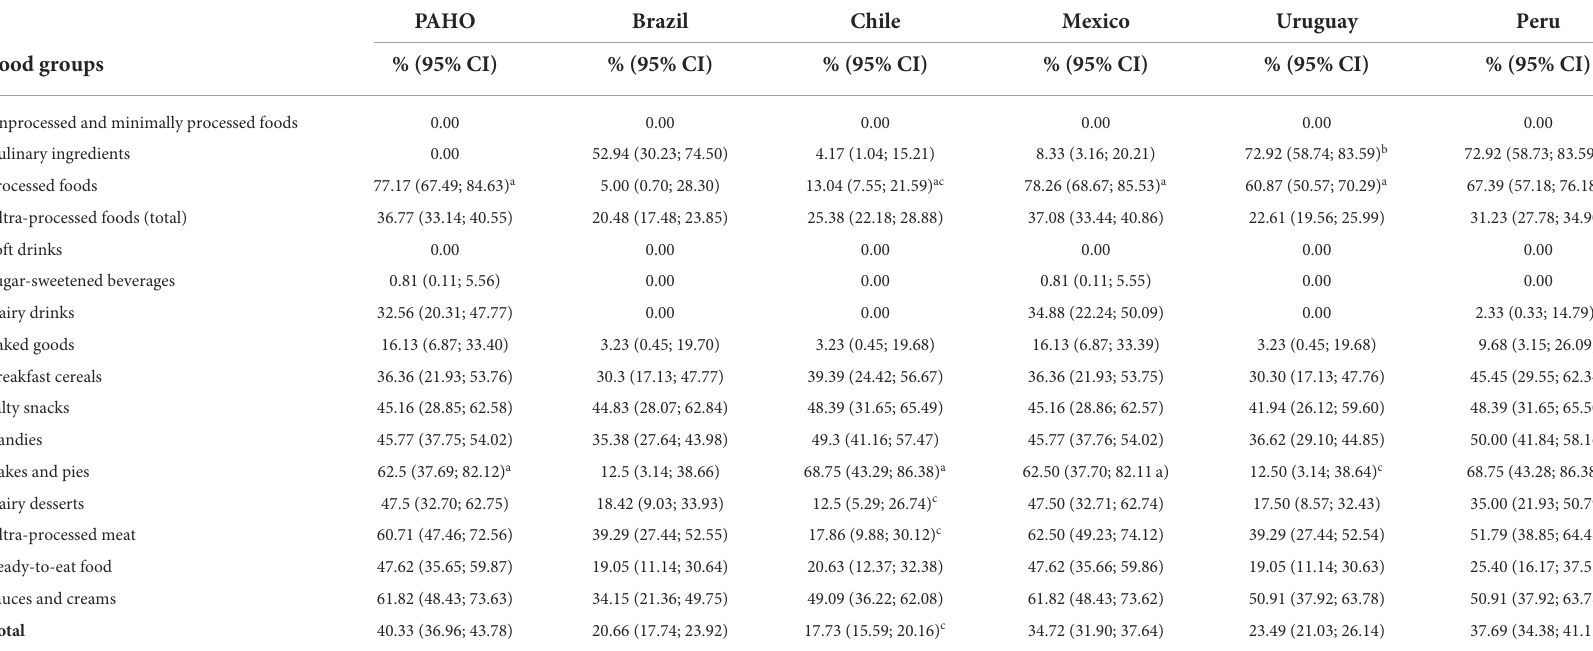
TABLE 5 Proportion (%) of foods and beverages with child-directed marketing and a high content of saturated fat according to different nutrient profile models (NPM), overall, and by food category (Brazil, 2017). PAHO Brazil Chile Mexico